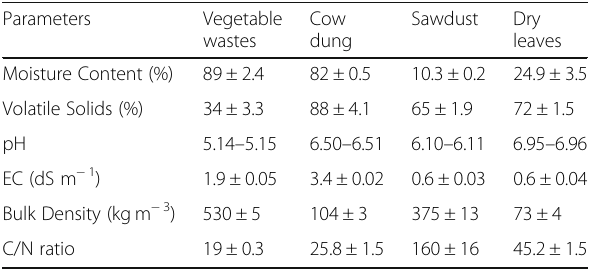
Table 1 Characteristics of composing materials used in this study